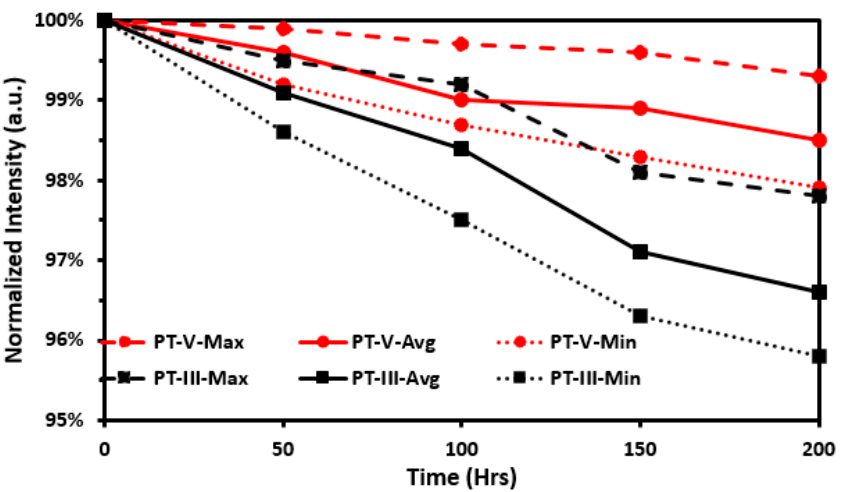
Figure 9. Reliability test results for 281 nm PT-III and PT-V DUV-LEDs.